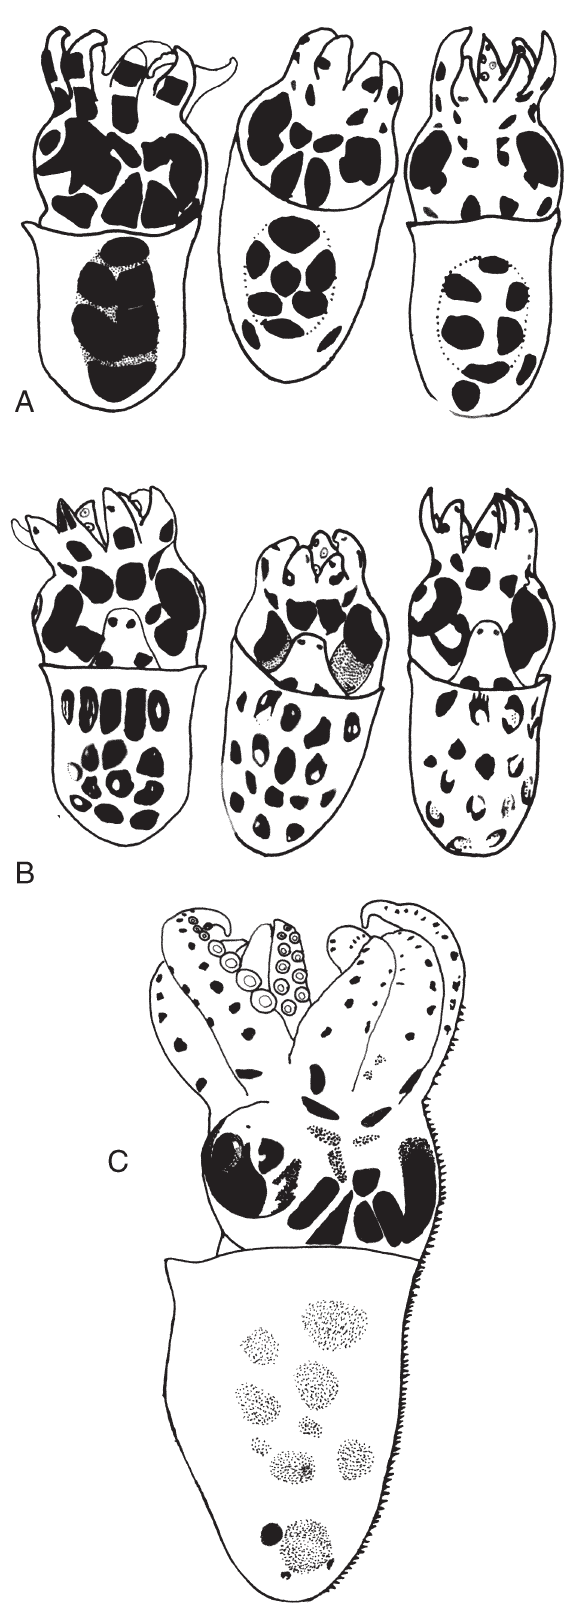
F IG . 9. – Different pigmentation views of Octopus vulgaris larvae (A: dorsal view, B: ventral view ML=2.5 mm, C: ML = 5.1